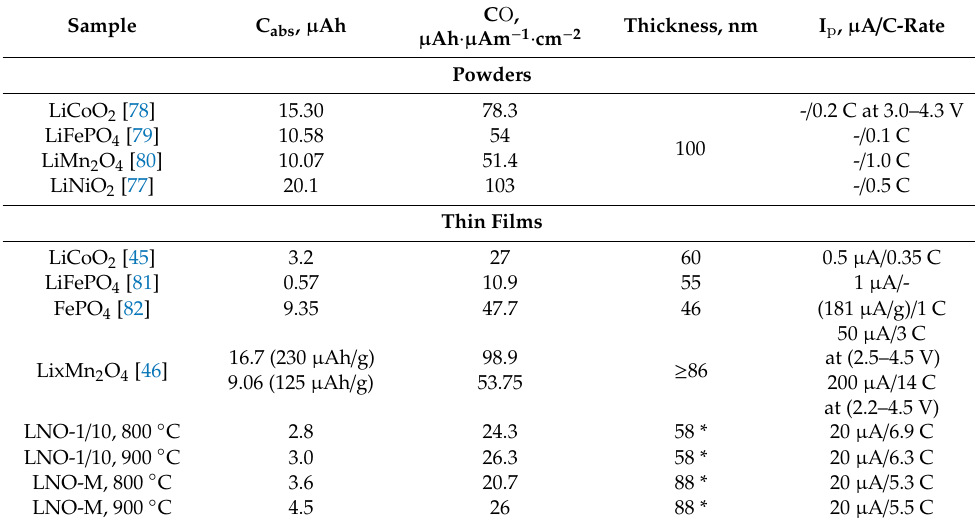
Table 5. Electrochemical characteristics of electrodes reported earlier and obtained in the present study.